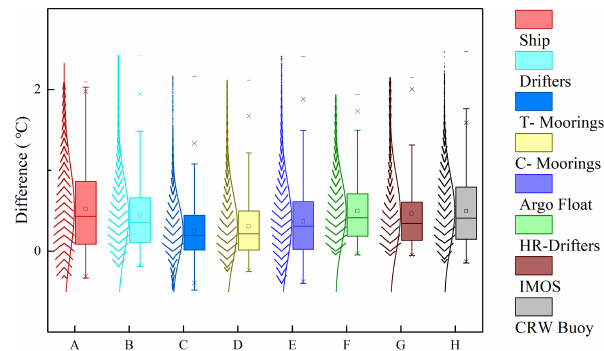
Figure 6. Box chart with scatters representing the differences be- tween the original MODIS data and eight types of in situ SST ob-